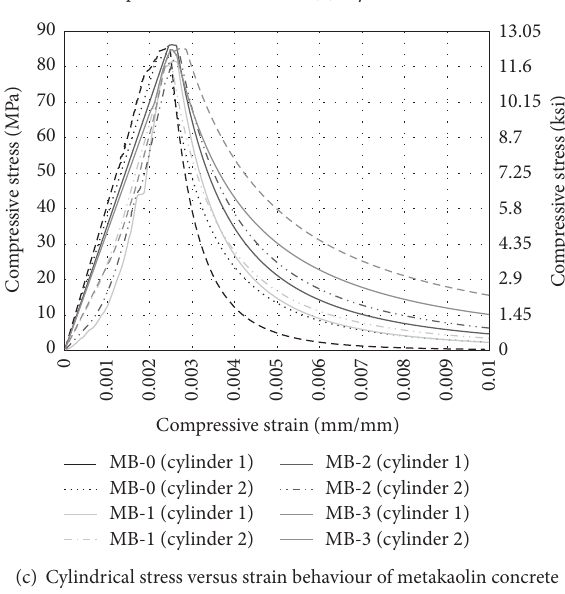
Figure 4: Cylindrical compressive strength versus strain